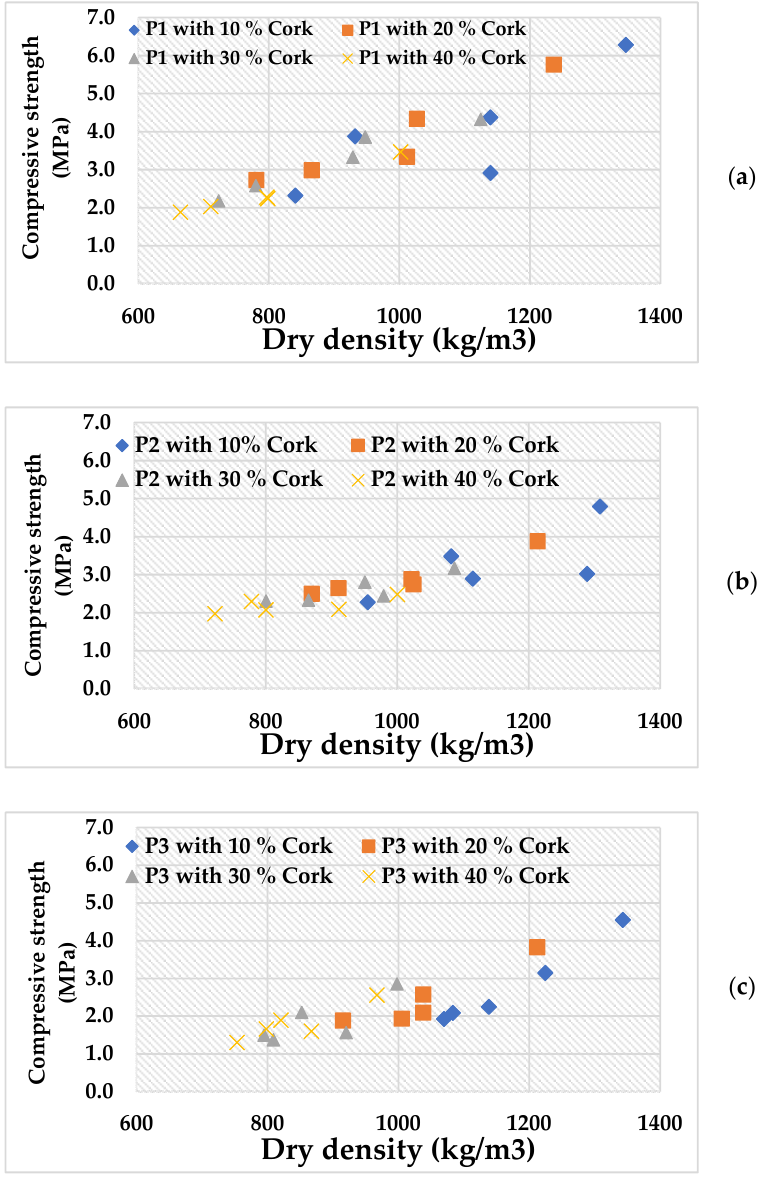
Figure 4. Correlation between dry density and compressive strength in the AA-LFM using Al powder varying from 0.009 w.% to 0.05 w.%; ( a ): P1 (<150 µ m), ( b ): P2 (<300 µ m), and ( c ): P3 (<500 µ m).